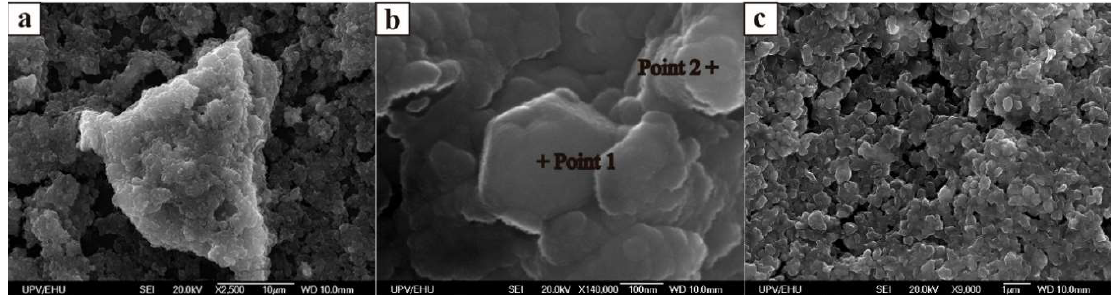
8 of 16 Figure 5. X-ray diffraction patterns of extracted binder fractions. ( a ) Fine fraction, ( b ) ultrafine fraction, and ( c ) target fraction. HC: hydrocalumite, HT: hydrotalcite, Qtz: quartz, Mg-Cal: magnesium calcite. These LDH mineral phases are formed as a result of the slaking process and identification and characterization is crucial due to their very high ability to fix carbonate anions [68]. During the rehydration process, CO 32− from the partial washing of unburnt fragments of limestone is fixed in the crystalline structure of HT-like minerals. The captured CO 32− introduces dead carbon in the system and ages the radiometric dates. A new step was introduced in the extraction procedure in order to remove the potential contaminant HT-like mineral phases in the ultrafine fraction (<0.5 µm). SEM observations of fine fraction (<2 µm) of the binder confirm the presence of very small HT-like particles embedded in a calcitic matrix (Figure 6). Irregular and hexagonal crystals of <0.5 µm grain size, corresponding to Ca-enriched or Mg-enriched anion clays, can be observed in Figure 6b. The Energy Dispersive X-ray (EDX) analyses indicate that well-formed or euhedral crystals correspond to Ca-enriched HT-like particles (point 1 in Figure 7) while the irregular or anhedral crystals correspond to Mg-enriched HT-like particles (point 2 in Figure 7). Therefore, Ca-enriched particles correspond to hydrocalumite and Mg-enriched particles to hydrotalcite. In fact, hydrotalcite is more likely to be present as a non-well-formed phase compared with hydrocalumite